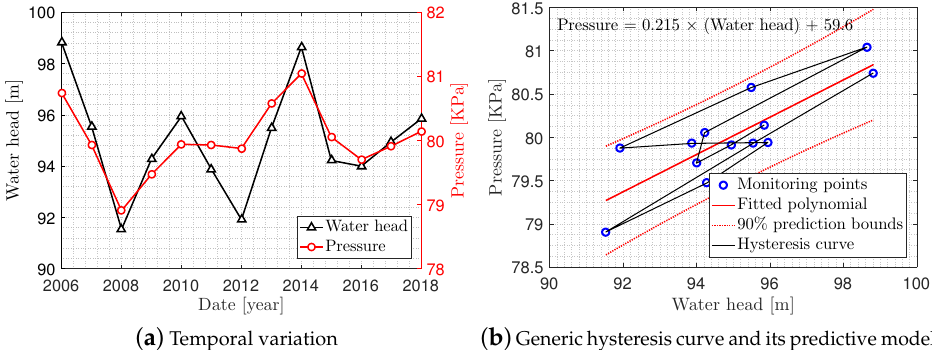
( b ) Generic hysteresis curve and its predictive model Figure 7. Developing a hysteresis curve.